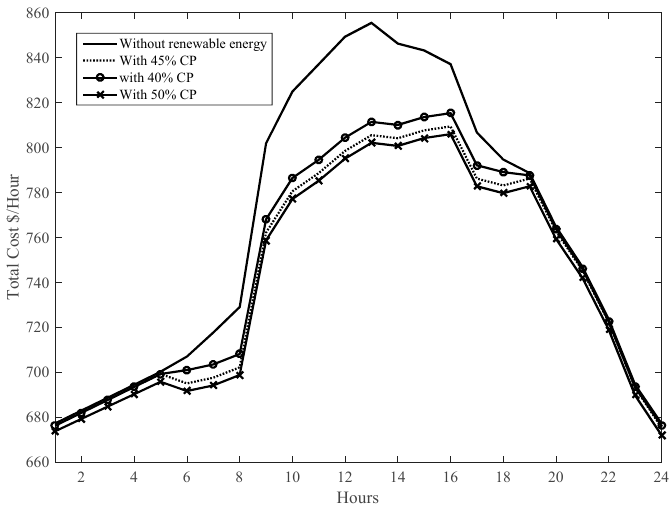
Figure 11. Effect of changing coefficient of performance on total cost.